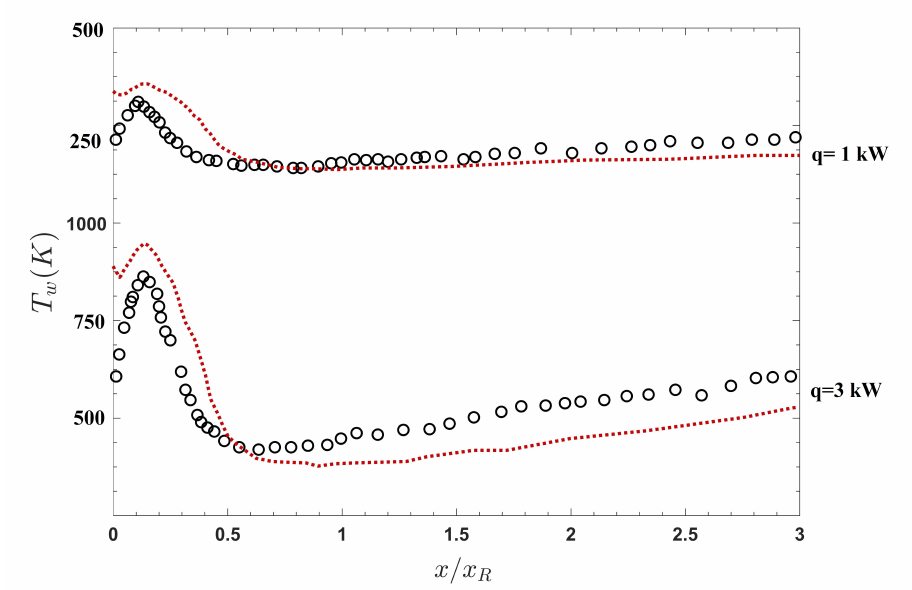
Figure 12. The mean temperature variation for the cases with intense wall heat transfer. IDDES (red dotted line), corresponding experiment